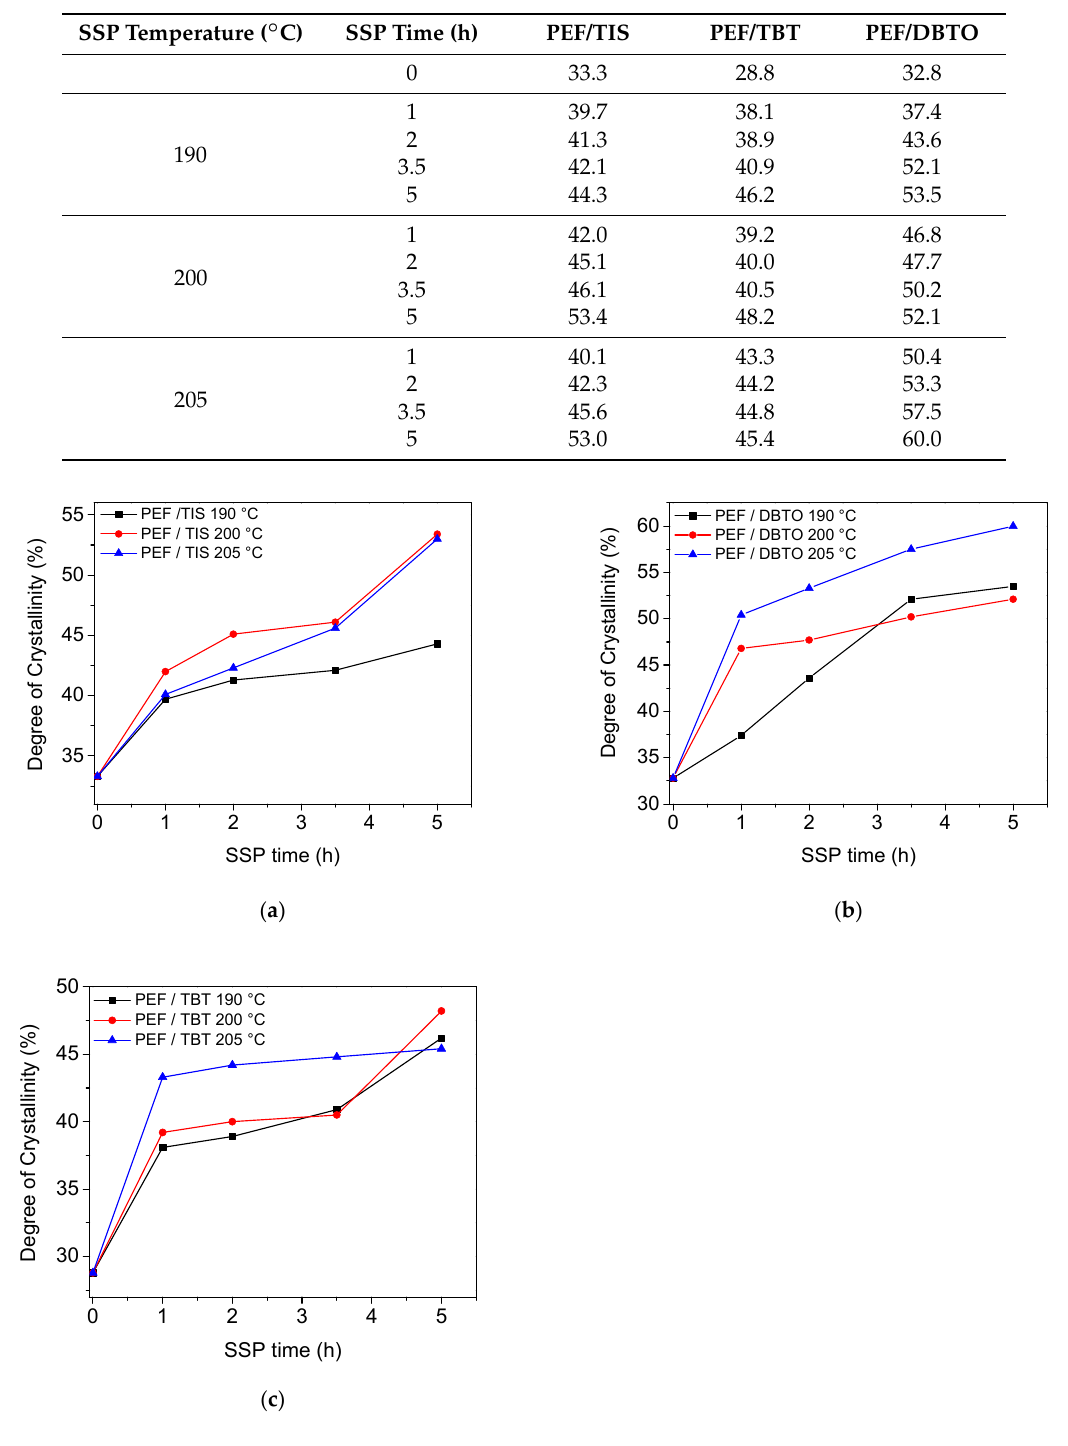
Figure 8. Effect of SSP time and temperature on the evolution of the degree of crystallinity of PEF samples using different catalysts: ( a ) PEF/TIS, ( b ) PEF/DBTO, ( c ) PEF/TBT.